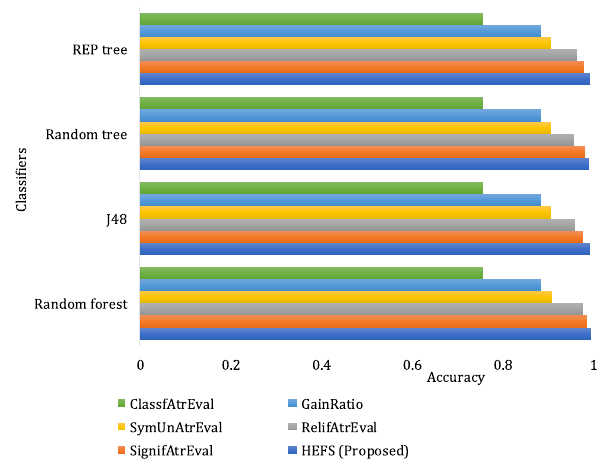
Fig. 5 Performance comparison of the HEFS method with the base selectors in terms of accuracy